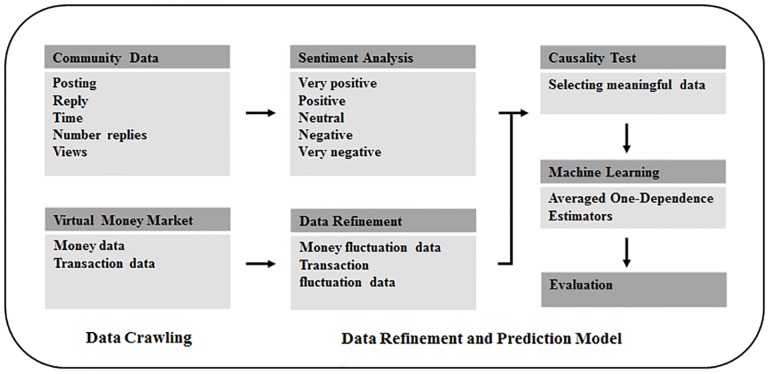
System overview.